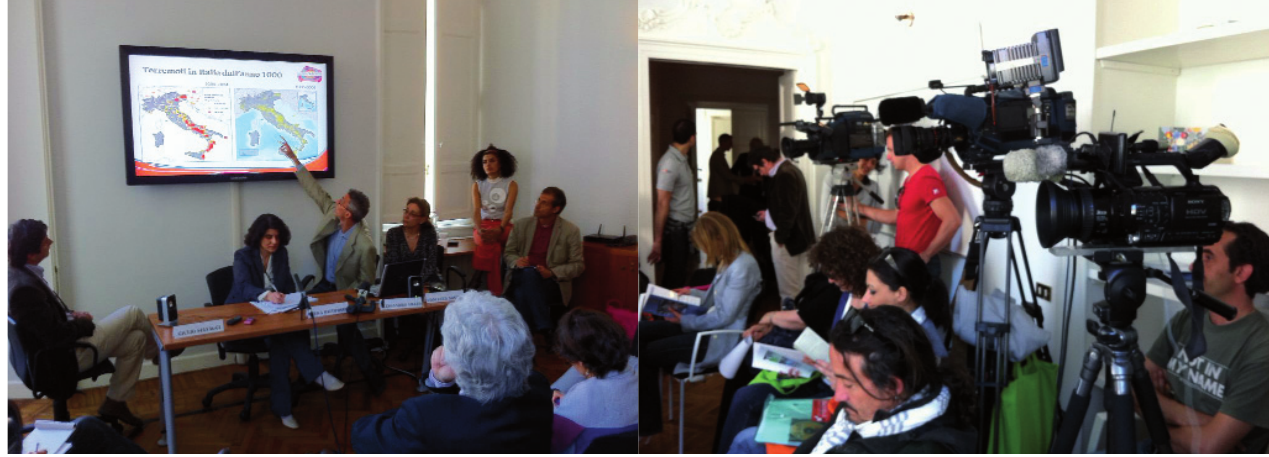
Figure 2. The press conference on May 9, 2011, held in the INGV office in the center of Rome, near the